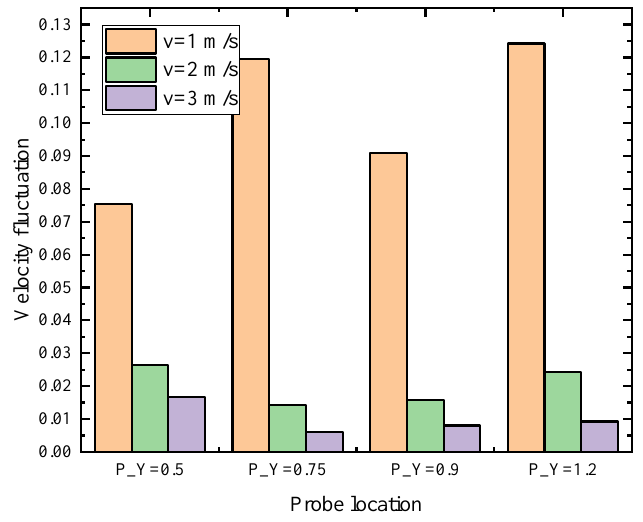
Figure 9. Effect of the inlet gas – liquid bubbly velocity on flow instability for various inlet velocities: